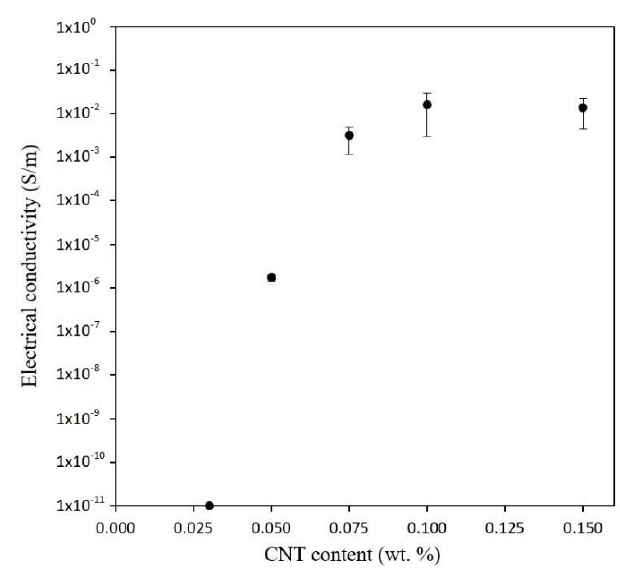
Figure 6. Electrical conductivity of 3D Printed specimens as a function of CNT content.